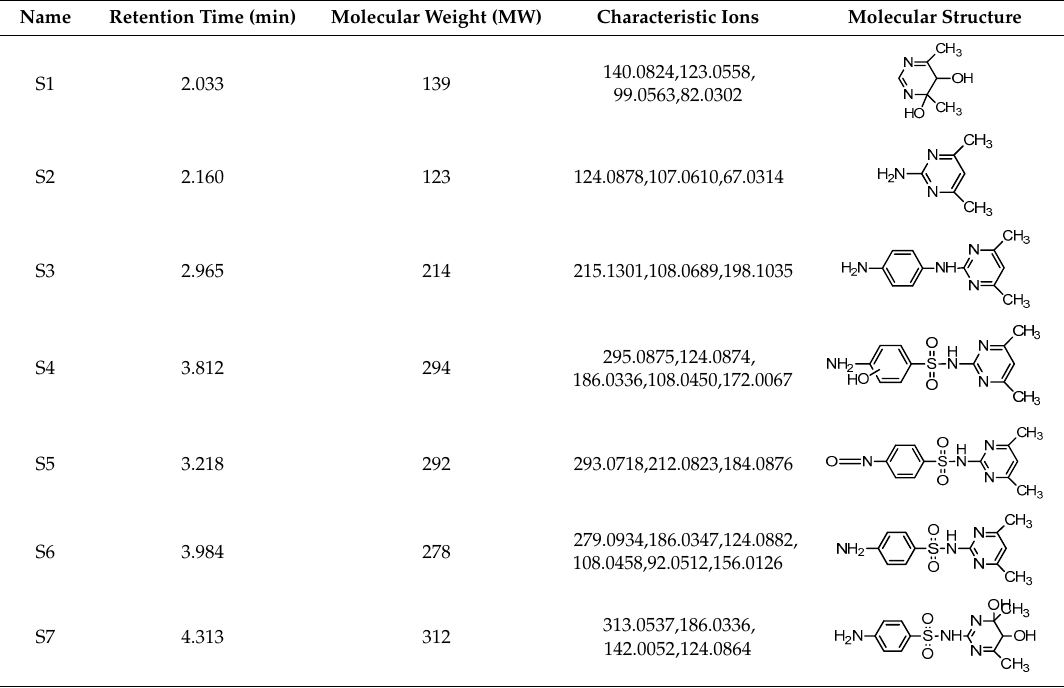
Table 3. The structure of transformation products and their MS fragmentation data in the UV/H 2 O 2 oxidation process of SMT.